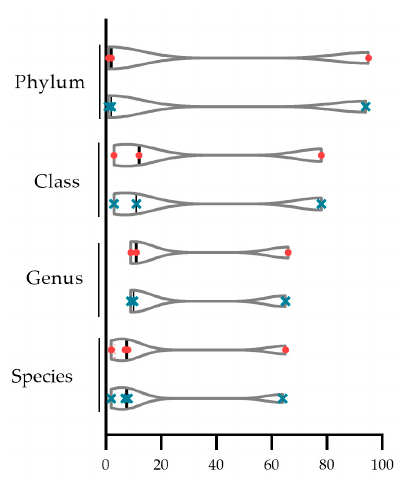
Figure 11. Statical comparison between the percentage distributions at the upper (phylum and class)